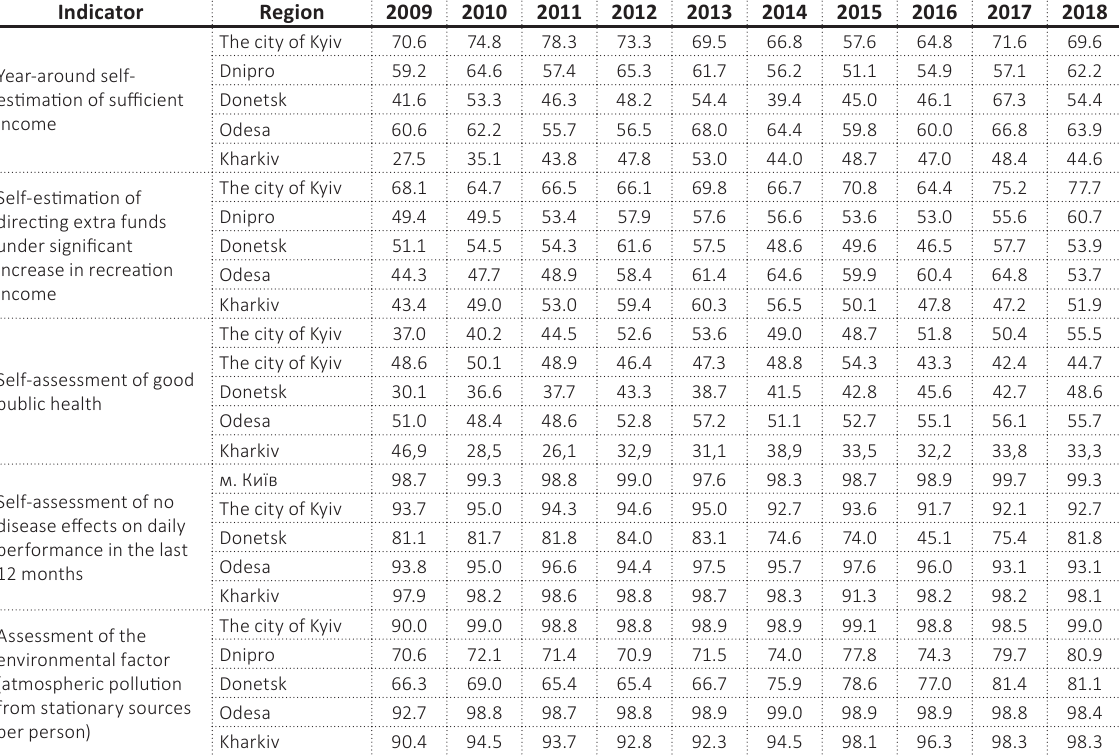
Table B1. Data for comparative assessment of wellness and recreation by regions with the largest urban agglomerations in Ukraine,